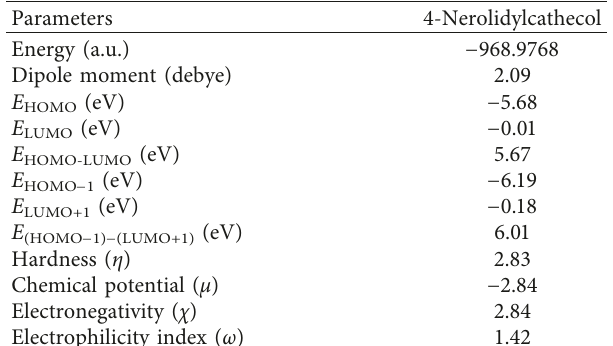
Figure 4: Frontier molecular orbitals of